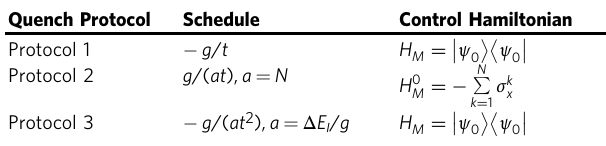
Table 1 Quantum annealing protocols with different interaction H M and schedule g ( t ), but of the same annealing time.